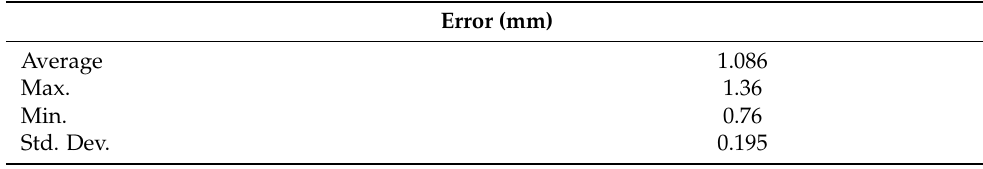
Table 1. Positioning error for static targets.